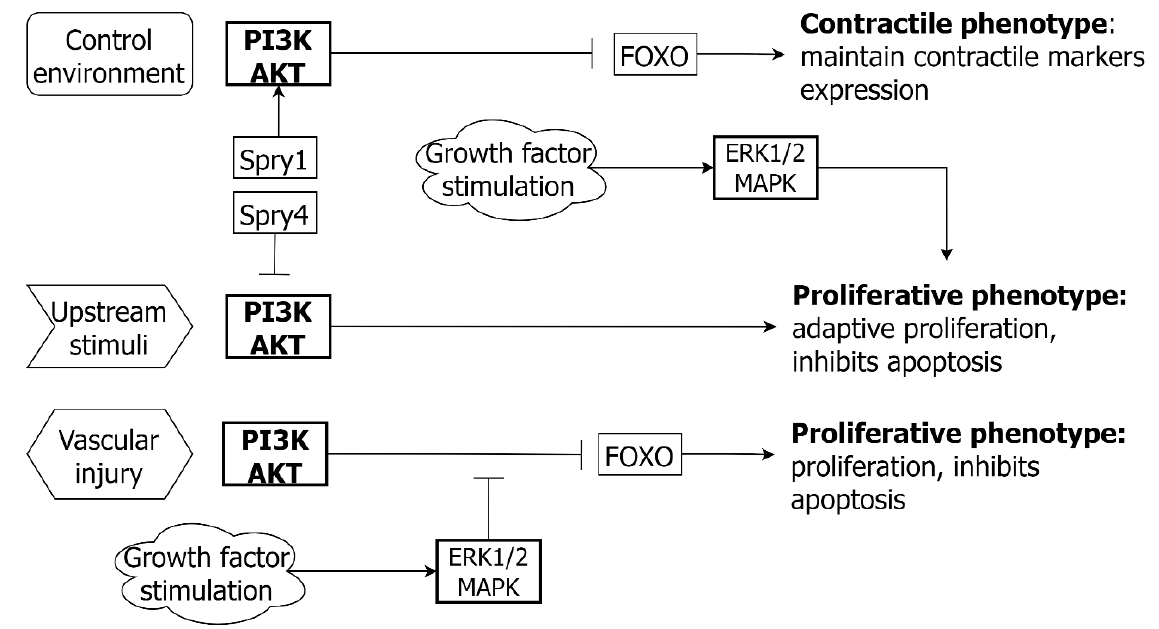
Figure 5. Summary of the mechanisms of PI3K/AKT signaling pathway in VSMC. In the basal state, AKT inhibition of FOXO contributes to maintenance of contractile phenotype. In response to growth factors or vascular injury, upregulated AKT signaling is associated with VSMC proliferation.